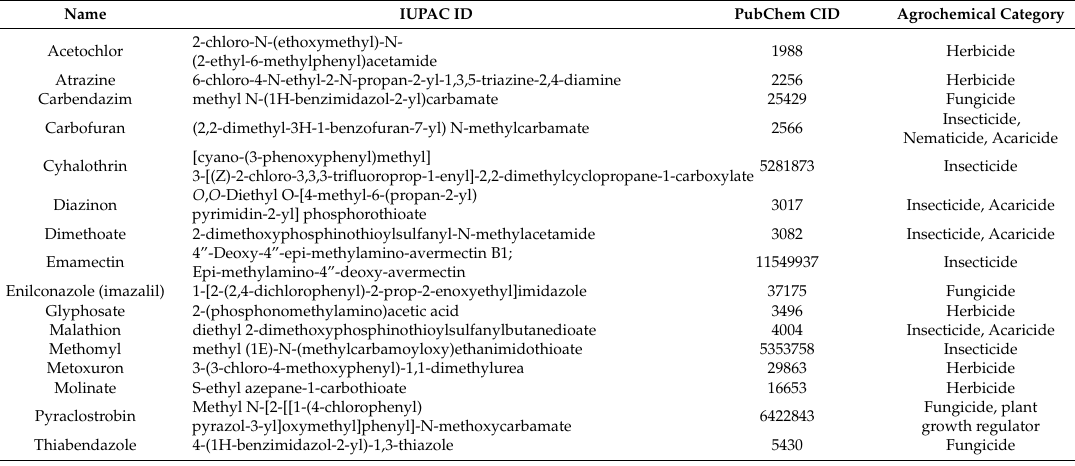
Table 1. Category of pesticides analyzed in urine samples from the two communities.